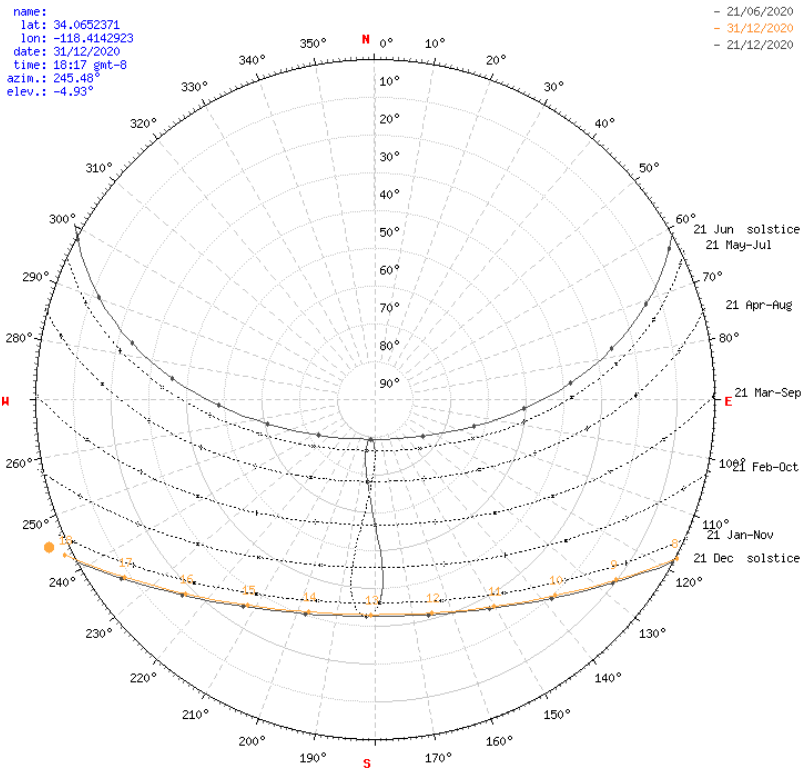
Figure 5. Sun path diagram for the city of Los Angeles, USA [28]. To find how the energy demand required for heating and cooling of the hotel is affected by the orientation, the orientation of the hotel relative to the north direction was varied from 0 ◦ to 355 ◦ with an increment of 5 ◦ . The result of these simulations is provided in Figure 6: